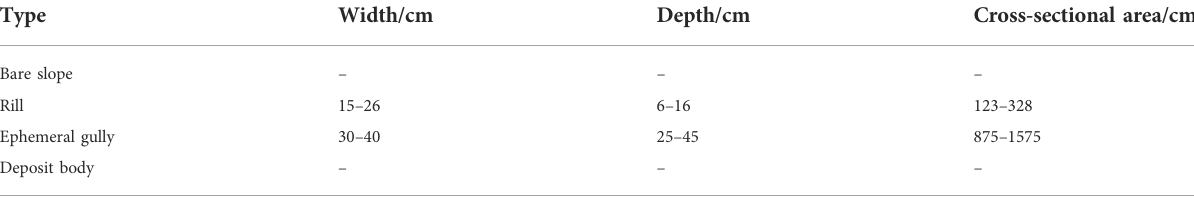
TABLE 2 Soil erosion characteristics of each